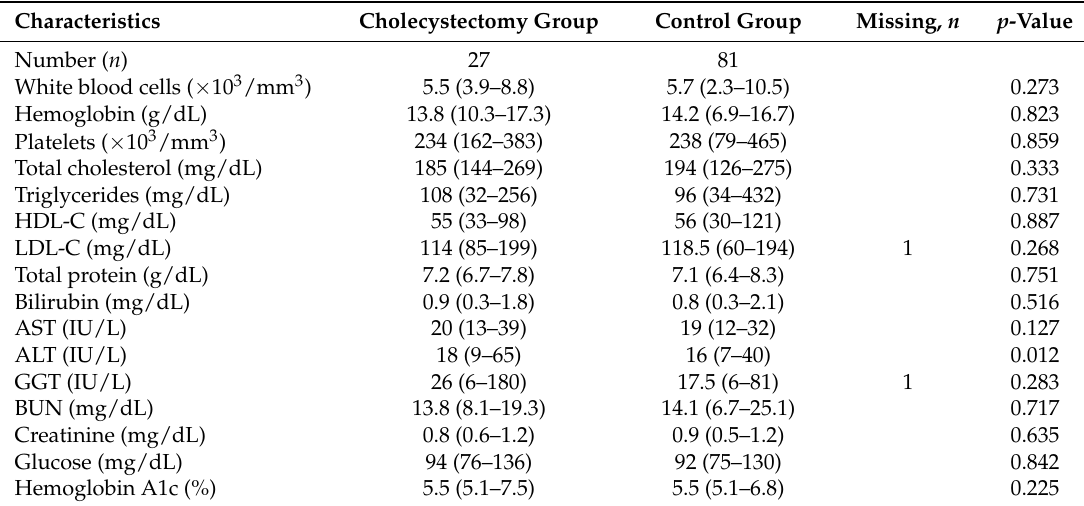
Table 2. Laboratory